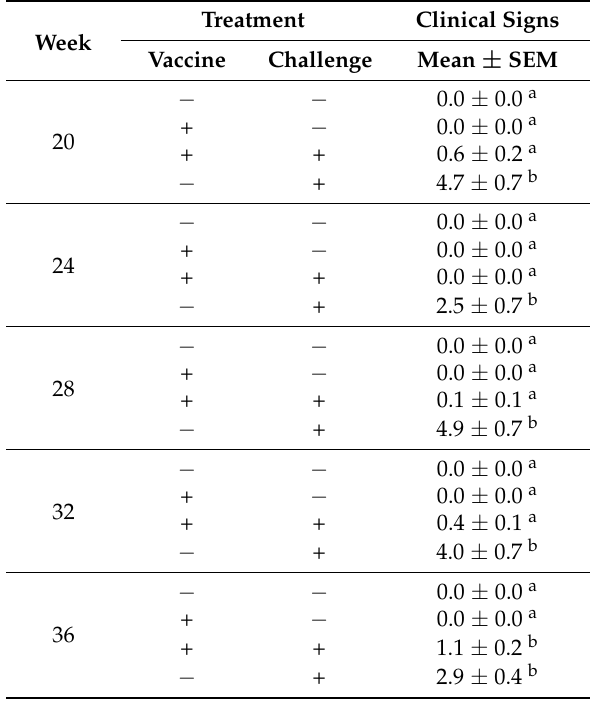
Table 6. Clinical signs measured 5 days following ILTV 63140 challenge. Letters (a–b) indicate significant differences among vaccine and challenge groups for each week ( p < 0.05).